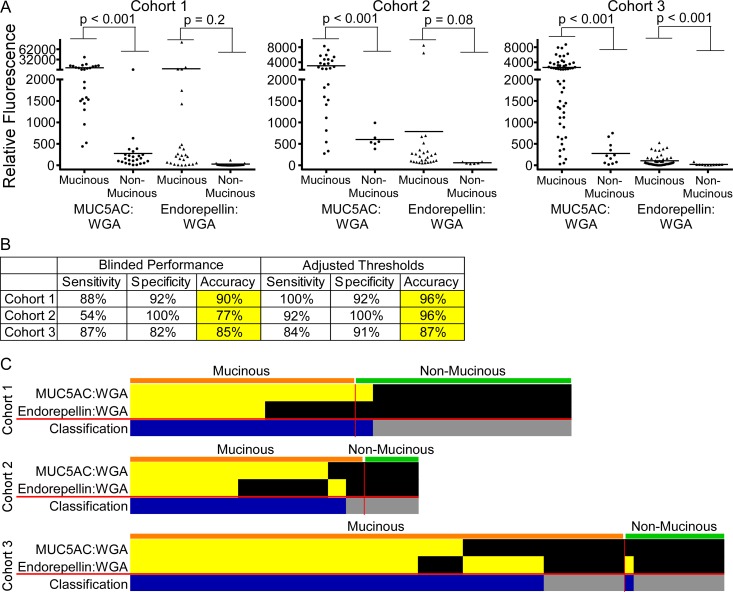
Validation of a previously-discovered biomarker panel.A) The individual biomarkers had significantly higher levels in mucinous cysts relative to non-mucinous cysts in all 3 cohorts. B) The combination of the two biomarkers shown in panel A distinguished mucinous from non-mucinous cysts with high accuracy. After determining the initial performance in each cohort, we adjusted the individual marker thresholds. The sensitivity in cohort 2 improved markedly after adjustment. C) The individual biomarkers showed elevations in non-identical mucinous cysts, rendering the panel more accurate than either marker used alone. Yellow boxes indicate measurements that were above a threshold for a particular marker. In the bottom row, blue boxes indicate samples with an elevation in either marker, classified as mucinous.